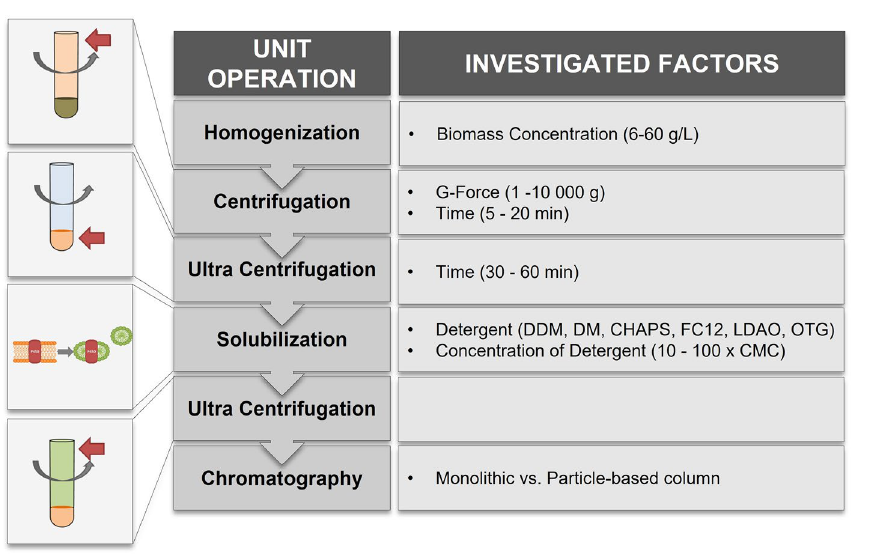
Figure 4. Unit operations necessary for the purification of recombinant Dv CH3H. Investigated factors and ranges thereof are shown in the right